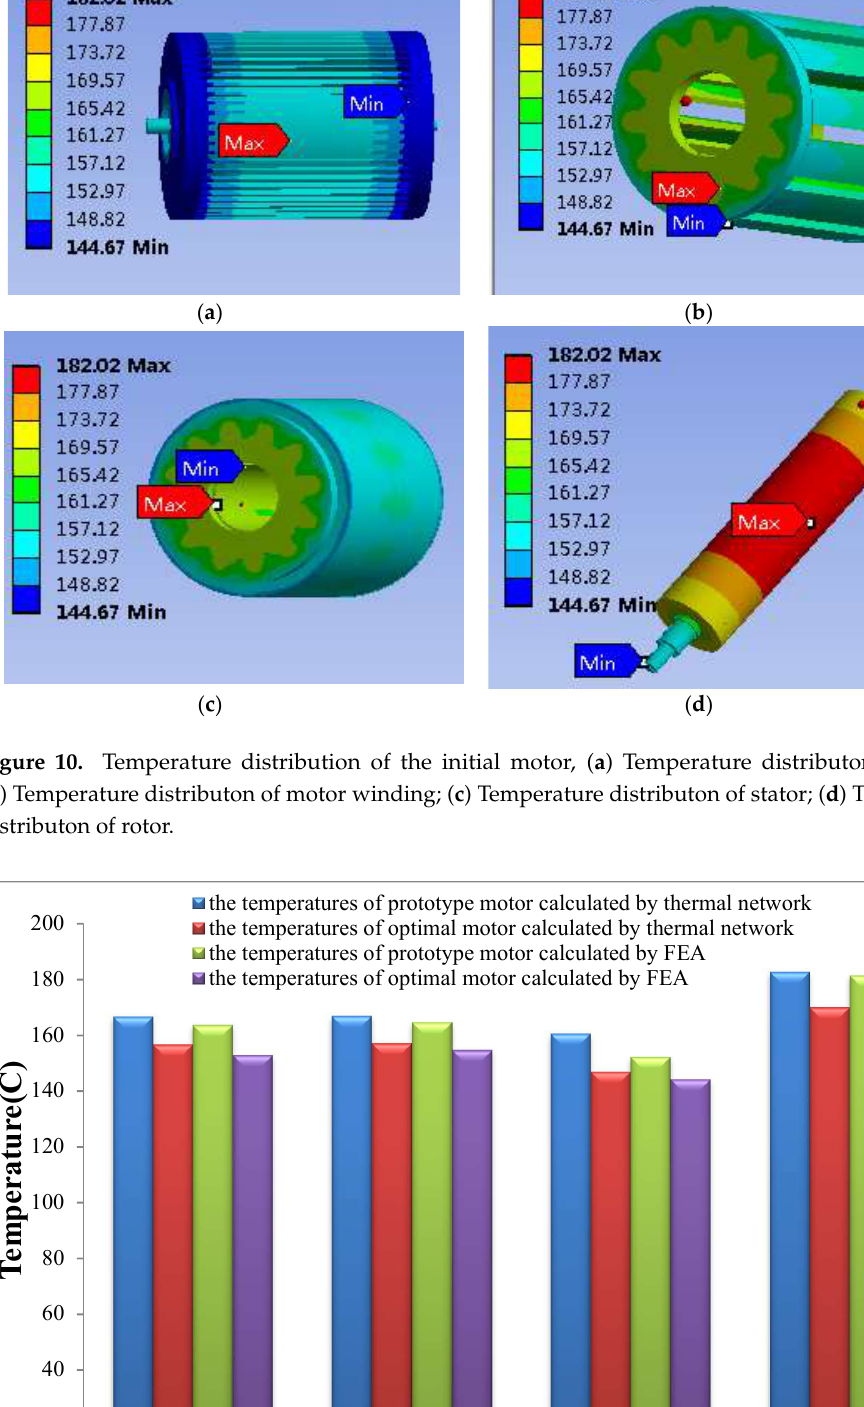
Figure 9. Temperature distribution of the optimal motor, ( a ) Temperature distributon of motor; ( b ) Temperature distributon of motor winding; ( c ) Temperature distributon of stator; ( d ) Temperature distributon of rotor.